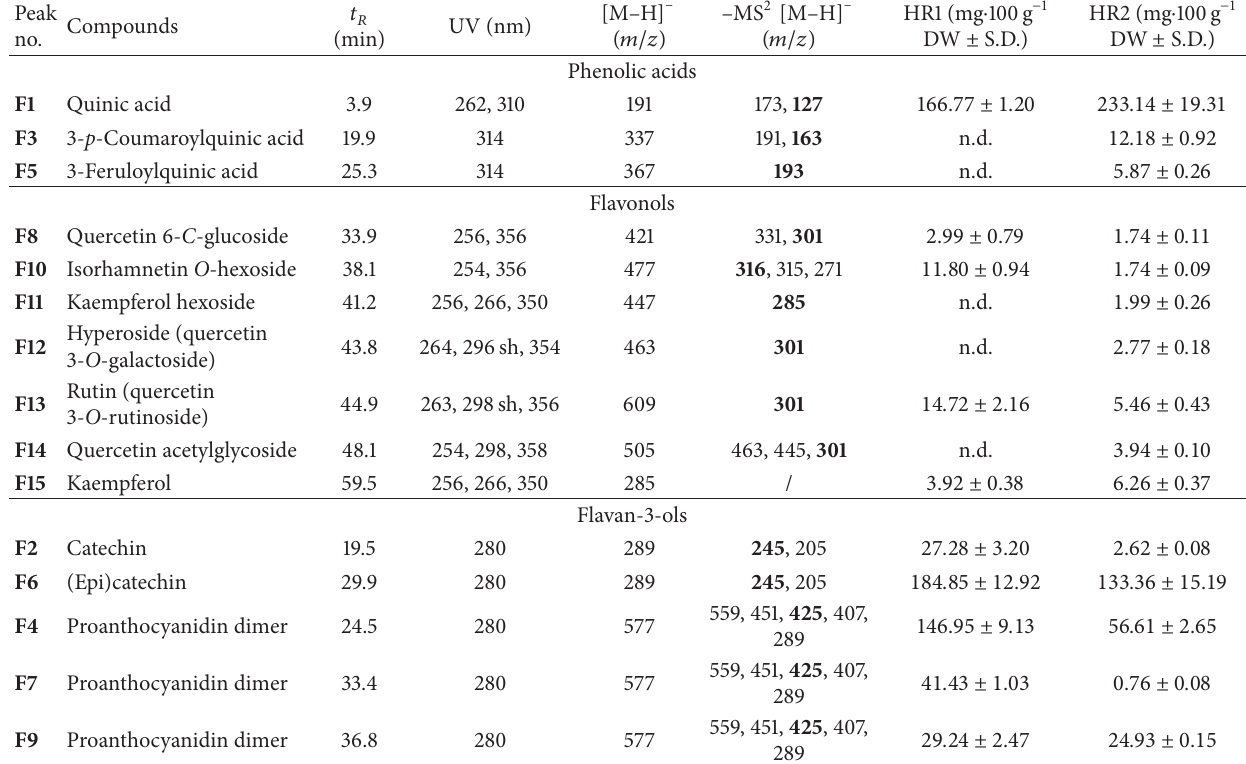
Table 1: Retention times, UV, and mass spectral data of phenolic acids, flavonols, and flavan-3-ols in Hypericum perforatum dark-grown (HR1) and photoperiod-exposed (HR2) hairy root culture extracts a .